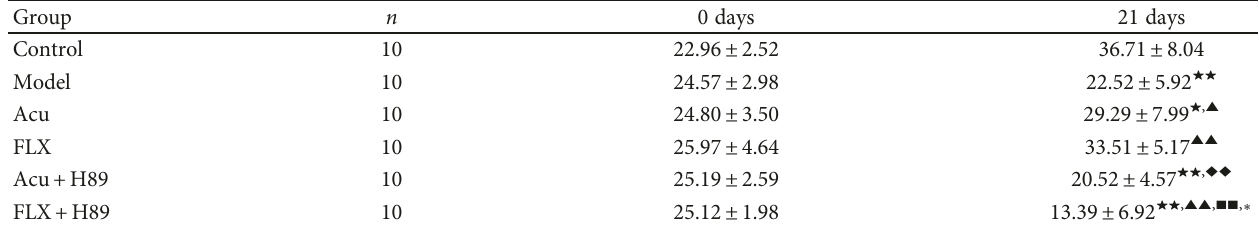
(b) Di ff erences in sucrose intake levels following stress/antidepressant